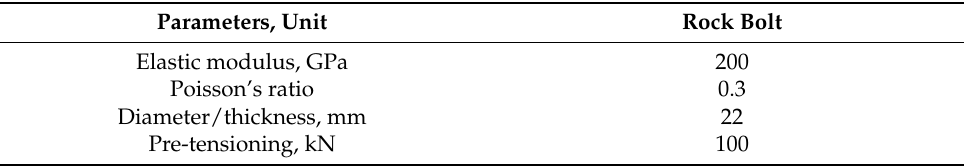
Table 5. The support materials used in the numerical simulation.